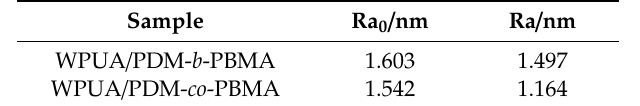
Table 5. The surface roughness of WPUA/PDM- b -PBMA and WPUA/PDM- co -PBMA films. Sample Ra 0 / nm